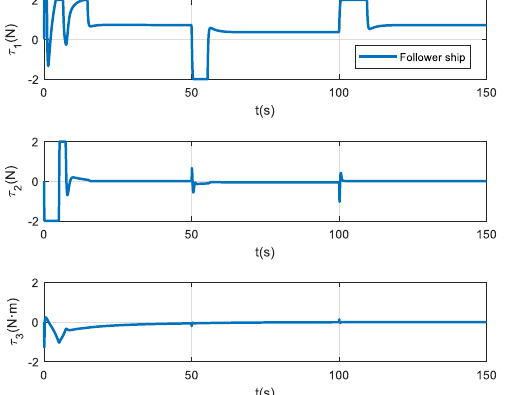
Figure 12. The synchronization of velocities with changes in velocities and course.